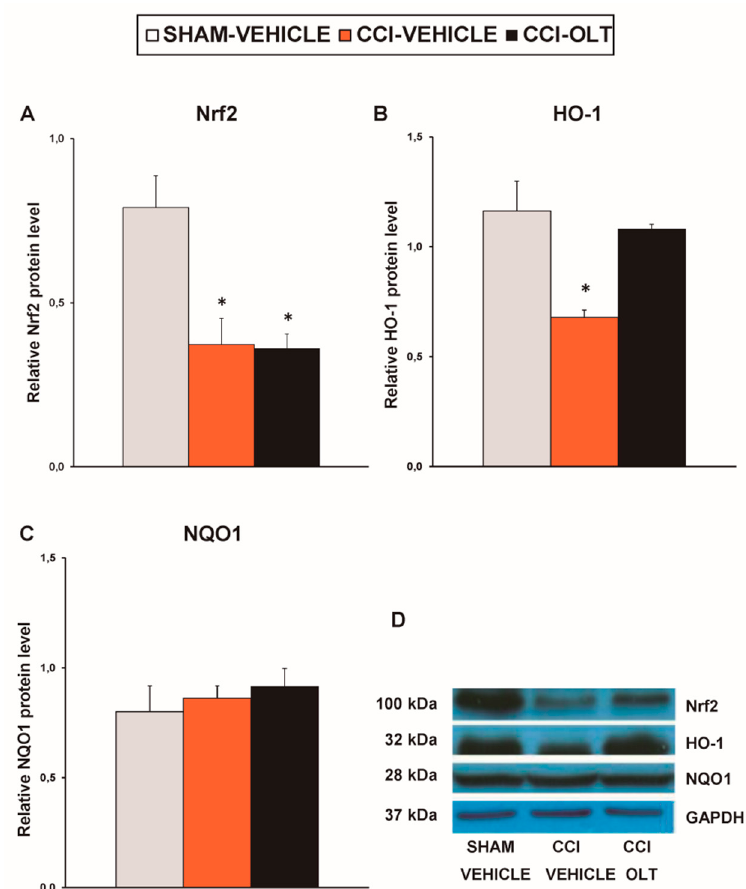
Figure 7. E ff ects of oltipraz on the expression of Nrf2, HO-1 and NQO1 in the hippocampus of the CCI-injured mice. The relative protein levels of ( A ) Nrf2, ( B ) HO-1, and ( C ) NQO1 in the hippocampus of the CCI-injured mice treated with oltipraz (OLT) or vehicle. The sham-operated mice (SHAM) treated with vehicle were used as controls. ( D ) Representative examples of blots for Nrf2 (100 kDa), HO-1 (32 kDa) and NQO1 (28 kDa) and GAPDH (37 kDa). Protein levels are expressed relative to GAPDH levels. In all panels, * denotes significant di ff erences vs. sham-operated mice treated with vehicle ( p < 0.05; one-way ANOVA followed by the SNK test). The results are presented as the mean ± SEM; n = 4–5 samples per experimental group.